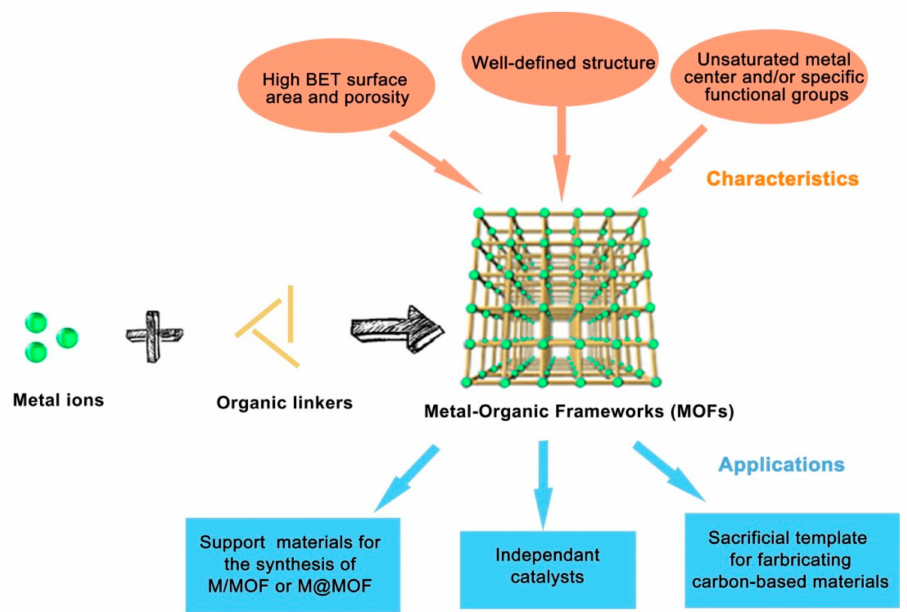
Figure 7. Illustration of MOF components, structure, characteristics, and mode of application. Reprinted with permission from Ref. [132]. Copyright 2018